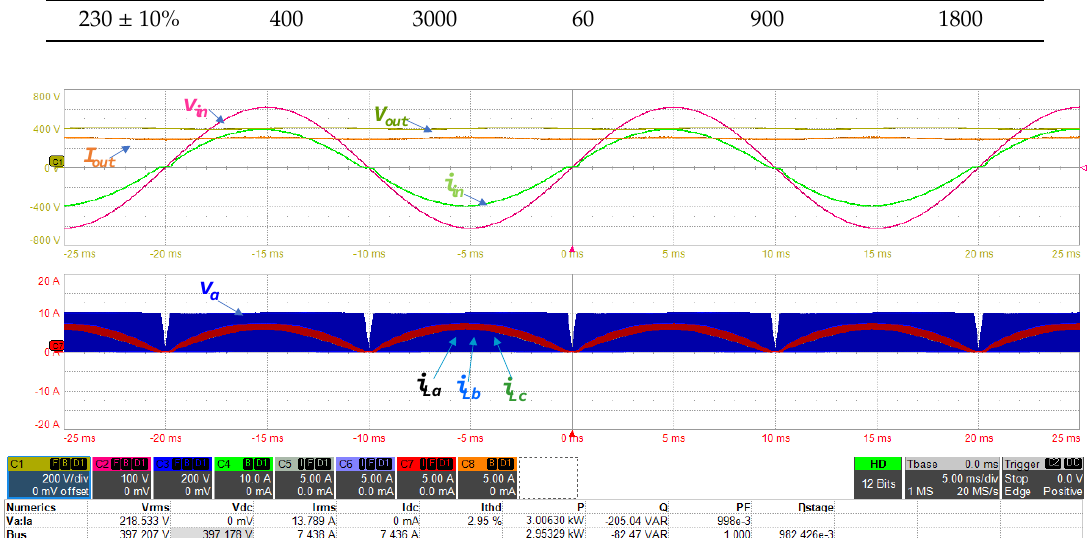
Figure 11. Switching waveforms of three cells interleaved PFC converter. v in = 100 V/div, i in = 10 A/div, V out = 200 V/div, I out = 5 A/div, i La = i Lb = i Lc = 5 A/div, v a = 200 V/div, P in = 3 kW, t = 5 ms/div.